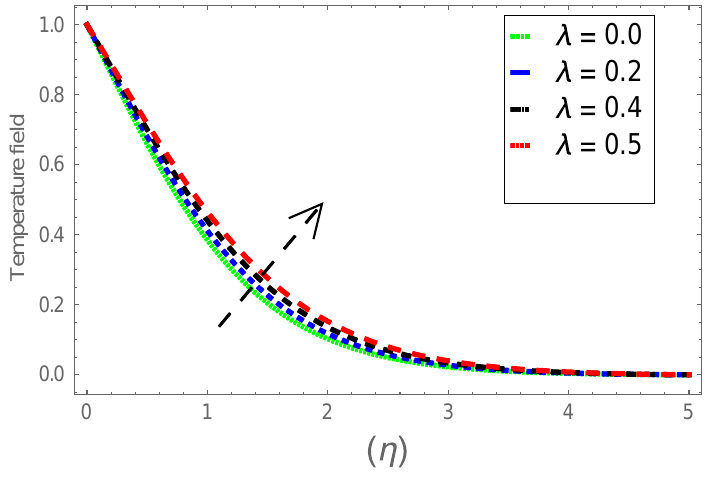
Coatings 2021 , 11 , x FOR PEER REVIEW